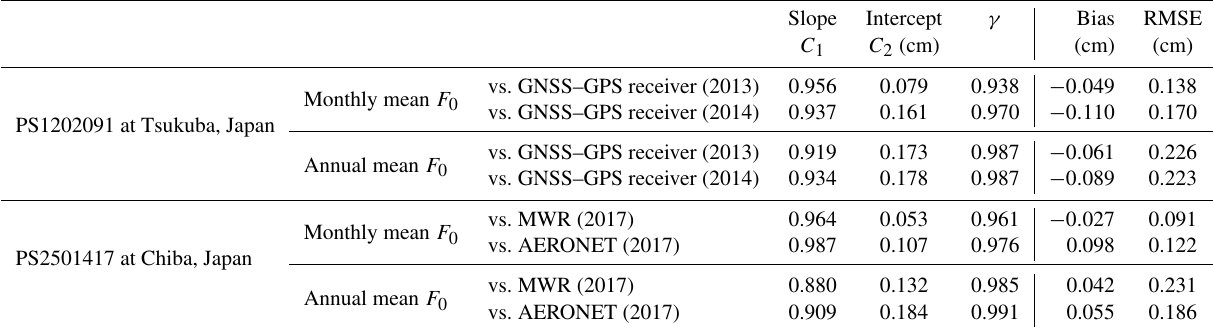
Table 5. Comparison of PWV between DSRAD and other instruments.